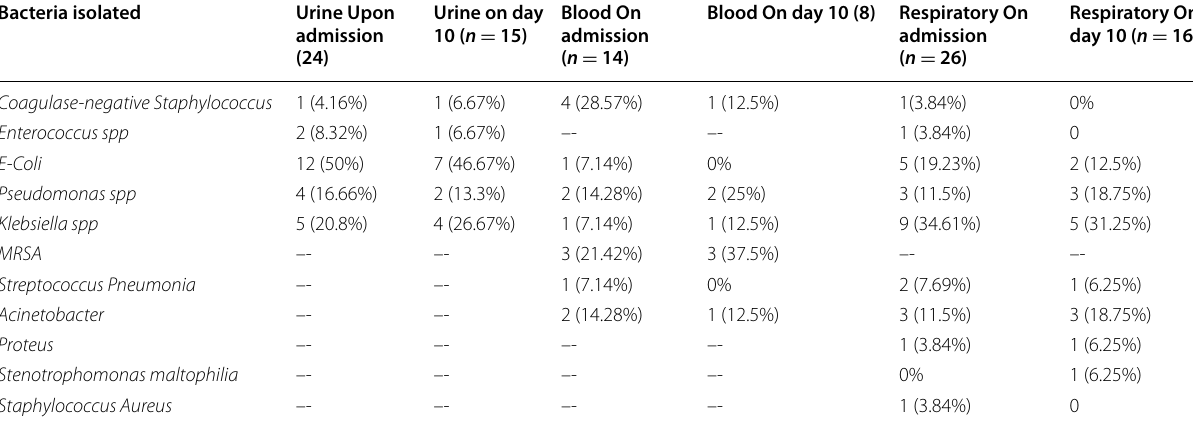
Table 6 Bacteria isolated from patients at admission and at day 10 Bacteria isolated Urine Upon admission